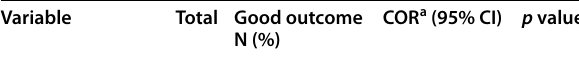
Table 3 The Association of expectations of parents before cochlear implantation, decision making process, barriers to quality care, and the outcome of children with cochlear